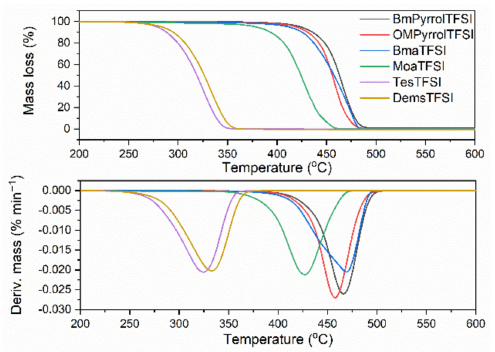
Figure 1. Thermogravimetric (TG) and derivative thermogravimetric (DTG) curves for ILs with TFSI anion. Table 3. Thermal stability of ILs with TFSI anion (T 5% , decomposition temperature at 5% of the